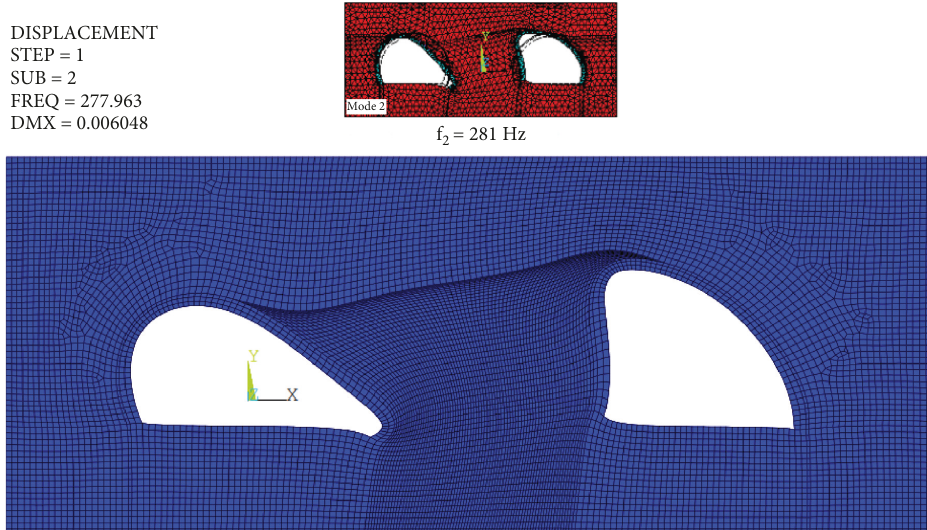
Figure 3: Comparison of validation modal analysis with Sevim (2011) article for the second vibrational mode of the Arhavi Tunnel in Turkey.